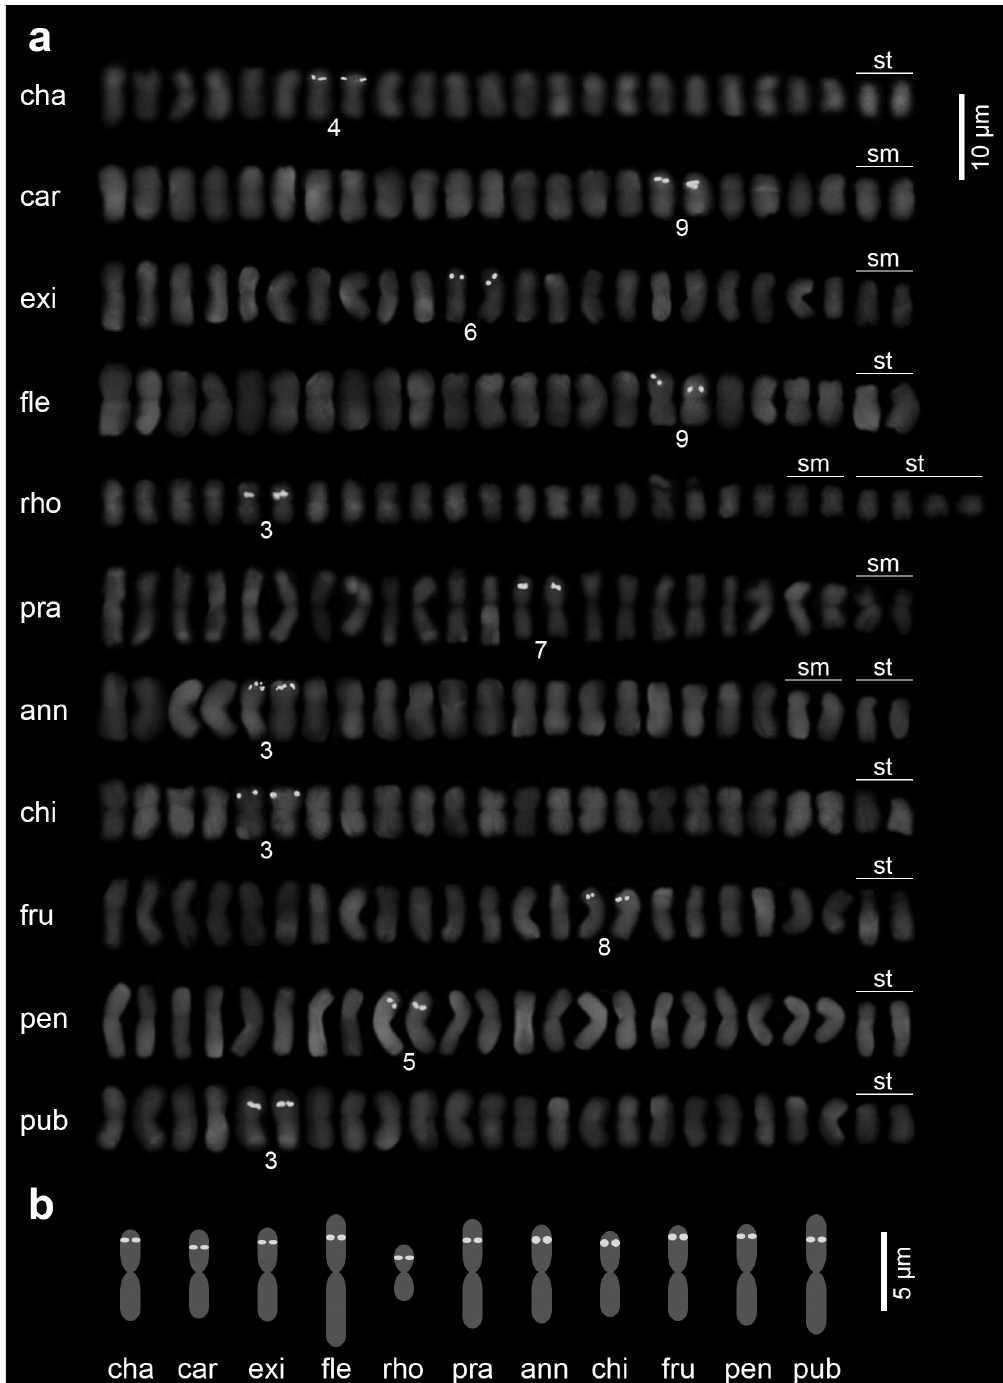
Figure 2 - Physical mapping of the 5S rDNA locus in the wild and cultivated Capsicum taxa by means of FISH. (a) Well-arranged karyograms derived from DAPI (blue) stained somatic metaphase plates showing the number and position of the 5S rDNA locus (green dots) added to further elementary cytological features; chromosomes other than metacentric (m) are solely marked (sm, st); (b) Schematic depiction of the chromosomes that carry the 5S rDNA locus considering the mean values described in Table I; green dots size relates to the mean fl uorescence intensity. (See the colors in the on-line